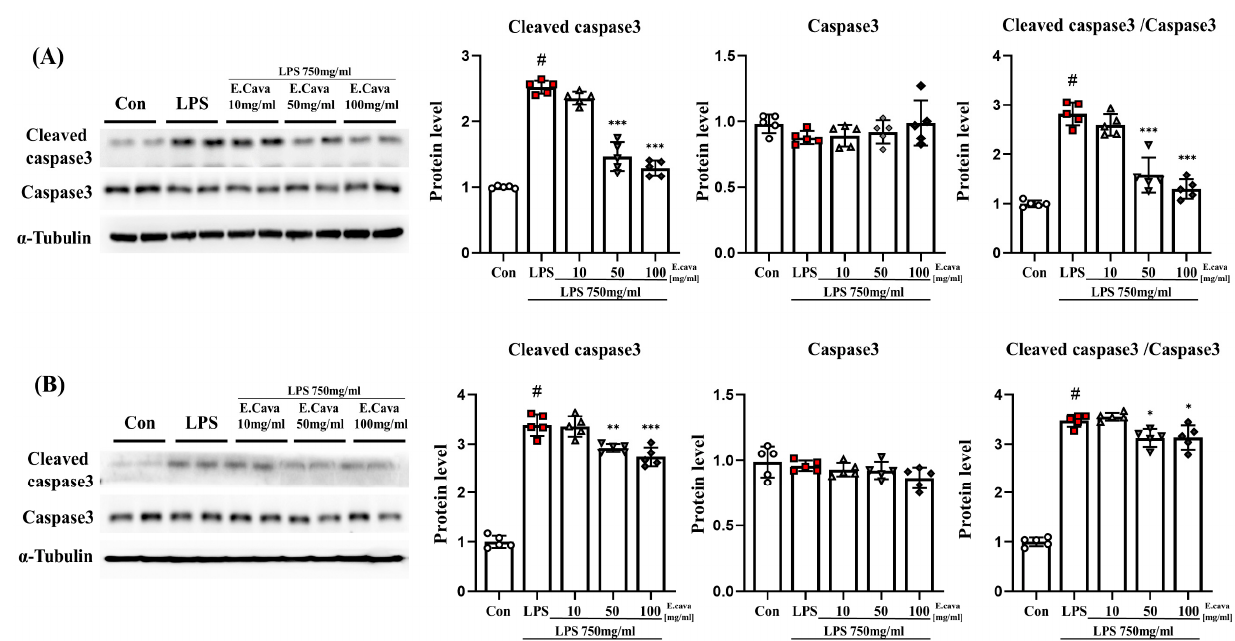
Figure 4. E. cava reduces apoptosis markers in mouse brains. ( A ) Western blot analysis and quantification of apoptosis-related genes were evaluated in the cerebrum of each group of male mice. ( B ) Western blot analysis and quantification of apoptosis-related genes were evaluated in the hippocampus of each group of male mice. Alpha-Tubulin was used for internal control. The points on the graph are represented by different shapes, with a white circle indicating the control group, a red square indicating the LPS group, a triangle representing the LPS + E. cava 10 mg/kg group, an inverted triangle indicating the LPS + E. cava 50 mg/kg group, and a rhombus representing the LPS + E. cava 100 mg/kg group. The differences between means were obtained through one-way ANOVA, and then a Tukey post-analysis. The values represent means ± S.D. # p < 0.001 vs. control group